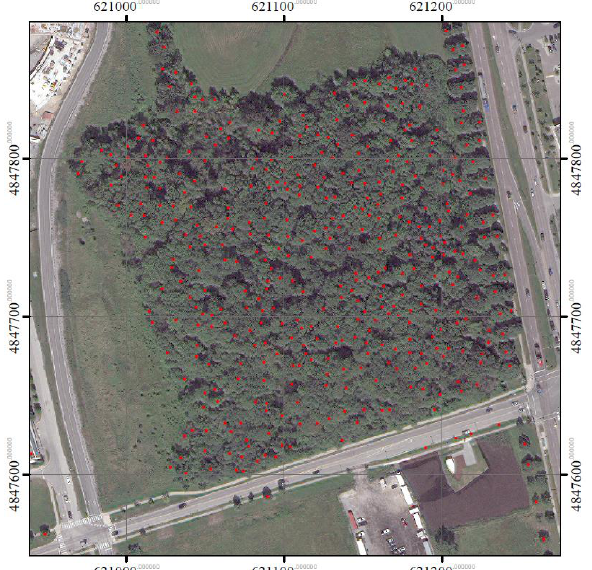
Figure 6: The detected trees for a woodlot subset using the combined worldview-3 imagery and airborne LiDAR data. The segments are overlaid on the true colour composite of workview-3 imagery.